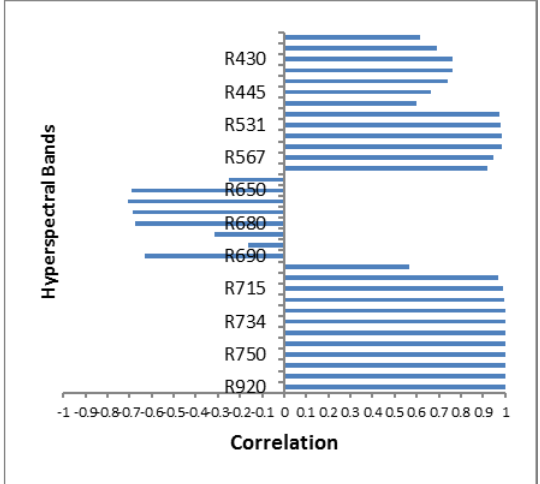
Figure 5. Correlation between chlorophyll content and Reflectance in narrow bands